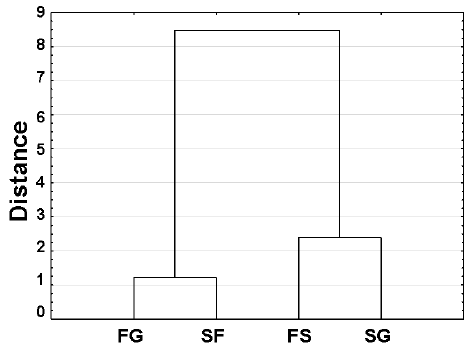
Figure 2. Dendrograms presenting multivariate similarity of the female turkey genotypes (SG – slow growing; FG – commer- cial fast growing; reciprocal crossbreed: SF (SG sires × FG dams); FS (FG sires × SG dams)), according to the examined blood pa- rameters: triglycerides, cholesterol, high-density lipoprotein, low- density lipoprotein, glucose and lactate based on cluster analysis (Ward’s method of agglomeration).